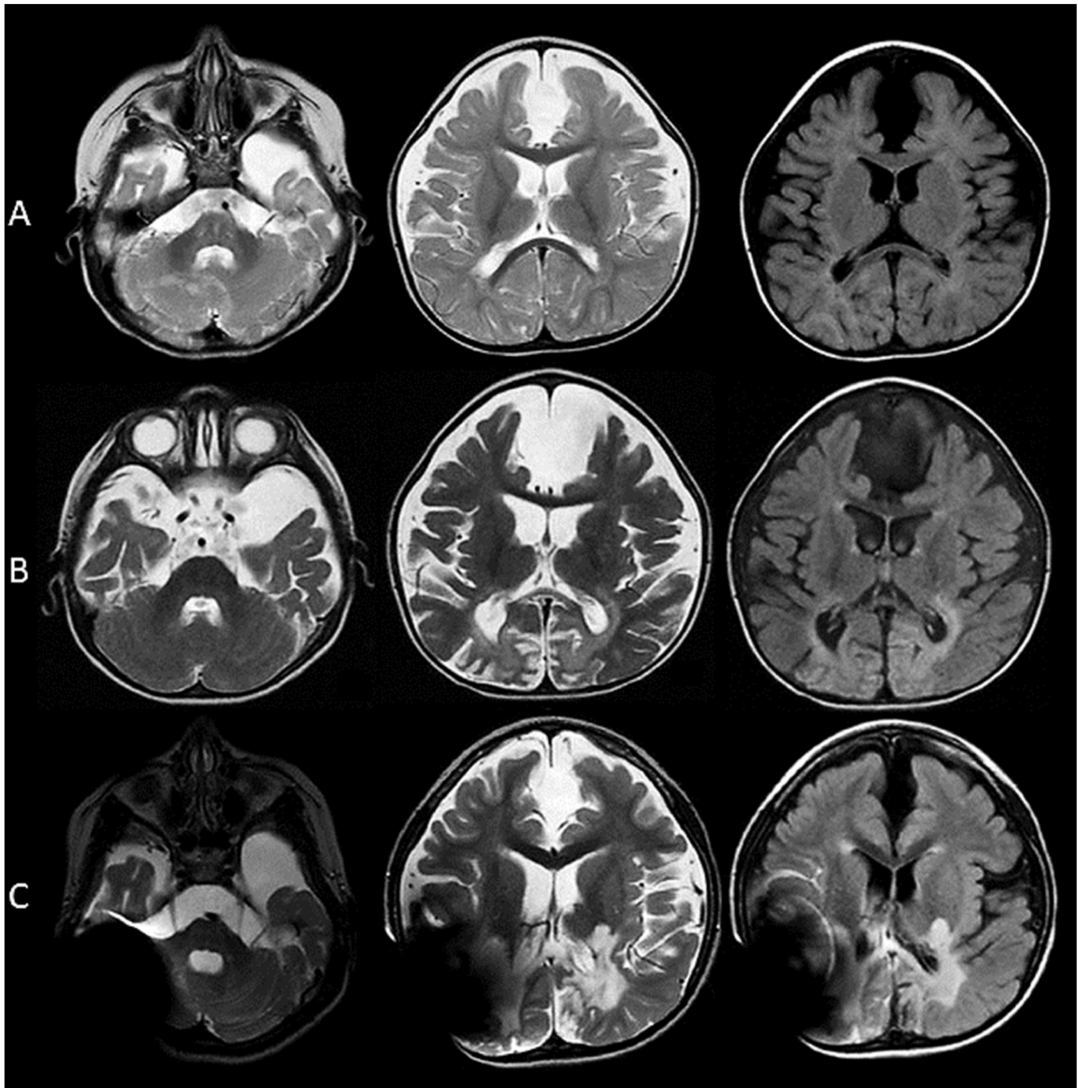
Figure 1. ( A ) At 10 months of age, a prominent subarachnoid space is evident, secondary to a mild degree of cortical atrophy, with a remarkable volume loss of the frontal and temporal operculum. The myelination for the age is adequate; also, interhemispheric and left temporal arachnoid cysts are seen. There is no di ff usion restriction in the DWI (Di ff usion-weighted Imagin) and ADC (Apparent Di ff usion Coe ffi cient) maps. ( B ) At 16 months of age, a marked generalized cortical atrophy is evident. In the T2-weighted and FLAIR images, areas of increased signal are observed predominantly in the deep white matter of the parietal and occipital lobes; also, gliotic changes are present bilaterally in the occipital poles. A compensatory ventriculomegaly is evident. There is no enhancement with gadolinium. ( C ) At 44 months of age, there is a large signal artifact which limits the observation of the right parietal, temporal, and occipital lobes, as well as the right cerebellar hemisphere. In the T2 and FLAIR images, there is an increased signal in the lateral aspect of thalamus bilaterally; the posterior arm of the internal capsules; the splenium of the corpus callosum; and again of the white matter of the temporal, parietal, and occipital lobes. Additionally, an increased signal is seen in the white matter of the left cerebellar hemisphere. A decreased volume of the brainstem is observed as